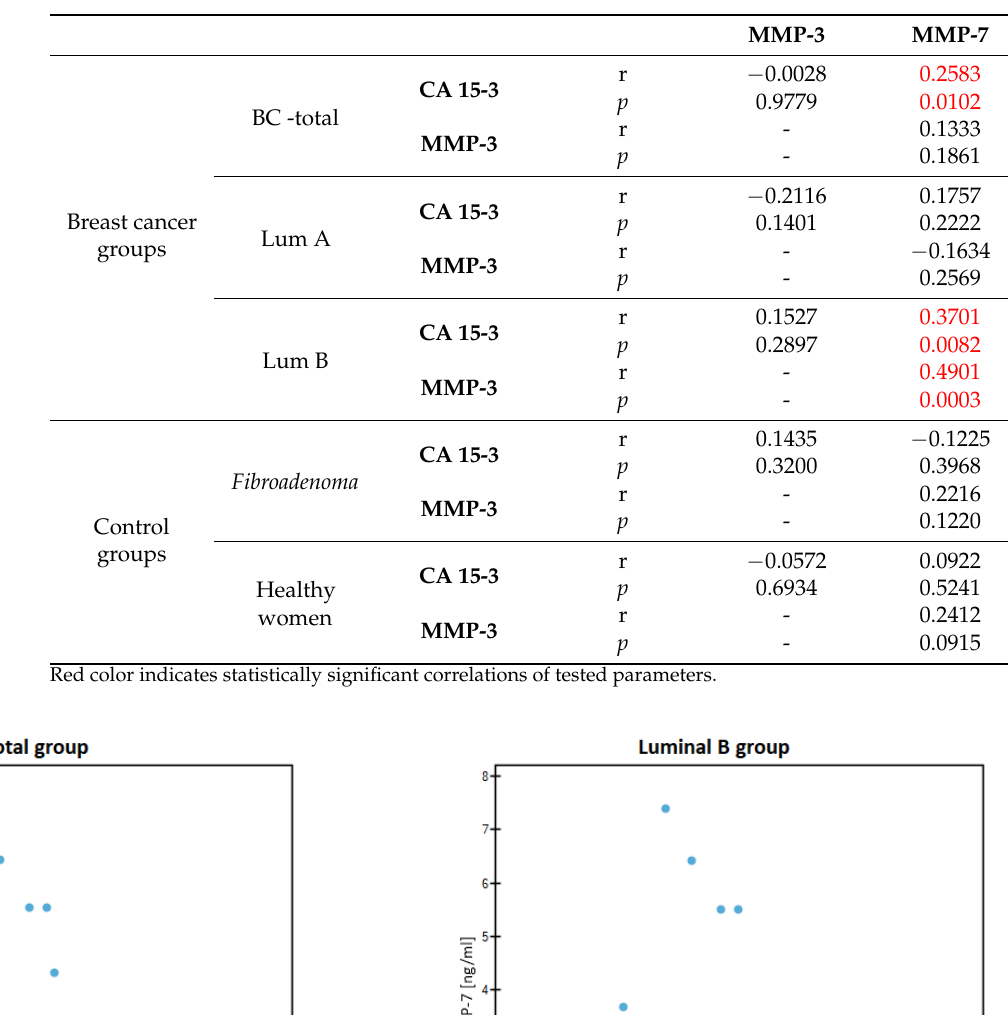
Table 4. The Spearman’s rank correlation test for MMP-3, MMP-7 and CA 15-3 in BC group of patients (total group and subgroups) and control groups.